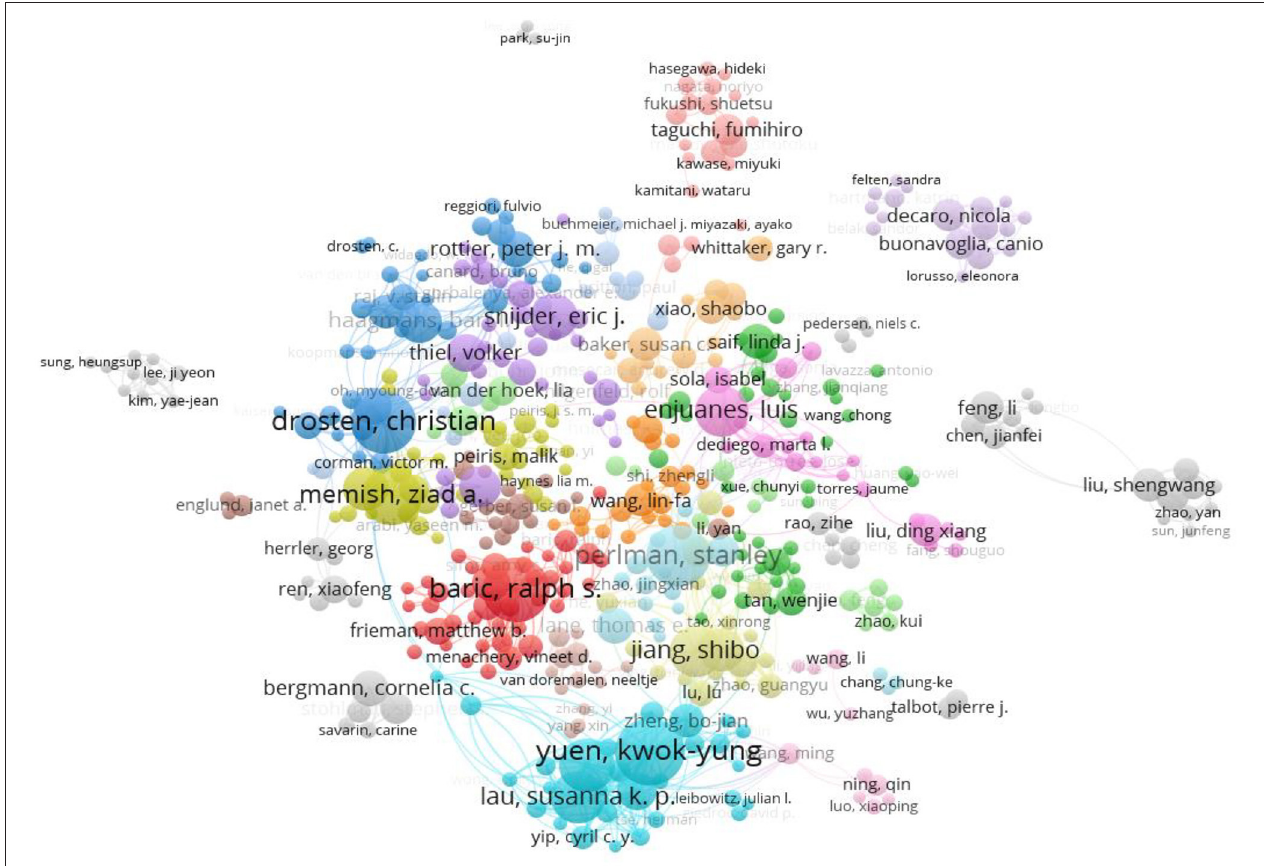
FIGURE 4 | Co-authorship network of CoV-related